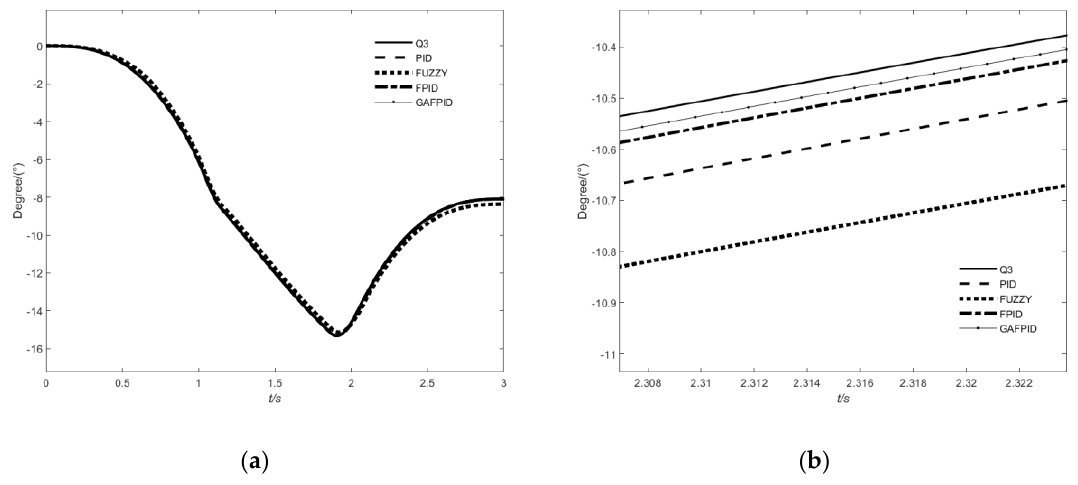
Figure 14. Joint trajectory Q3: ( a ) tracking response; ( b ) local enlarged view.